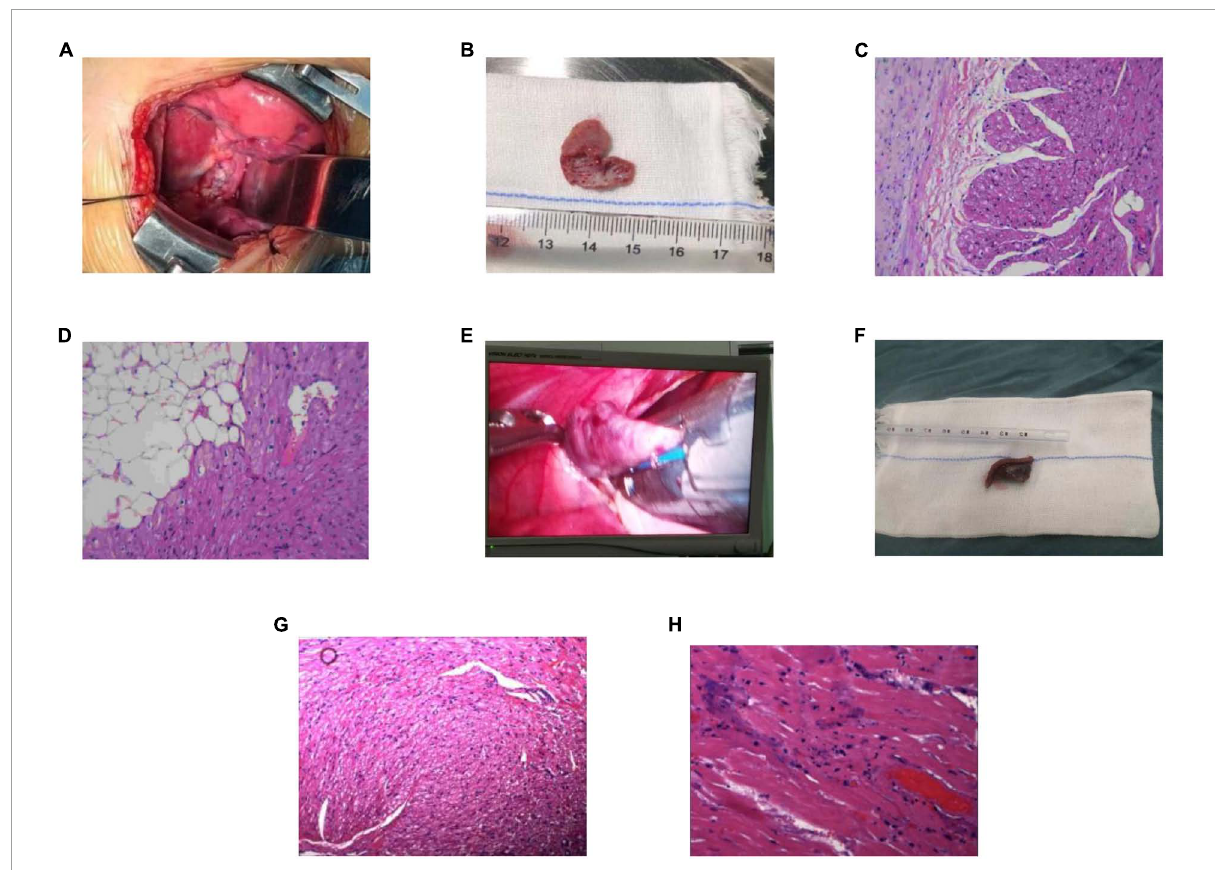
FIGURE3 Excised atrial appendage and pathology (200 × ). (A) Case 2: the image of the left atrial appendage (LAA) during the operation. (B) Case 2: the excised LAA. (C,D) Case 2: postoperative pathology. Striated muscle and fibrous adipose tissue of LAA, local tissue degeneration. (E) Case 3: the image of the right atrial appendage (RAA) during the operation. (F) Case 3: the excised RAA. (G,H) Case 3: postoperative pathology. The arrangement of myocardial fibers in the RAA was disordered, some myocardial nuclei were enlarged, some muscle fibers showed granular degeneration and vacuoles, and tiny necrosis foci could be seen locally. LAA, left atrial appendage; RAA, right atrial